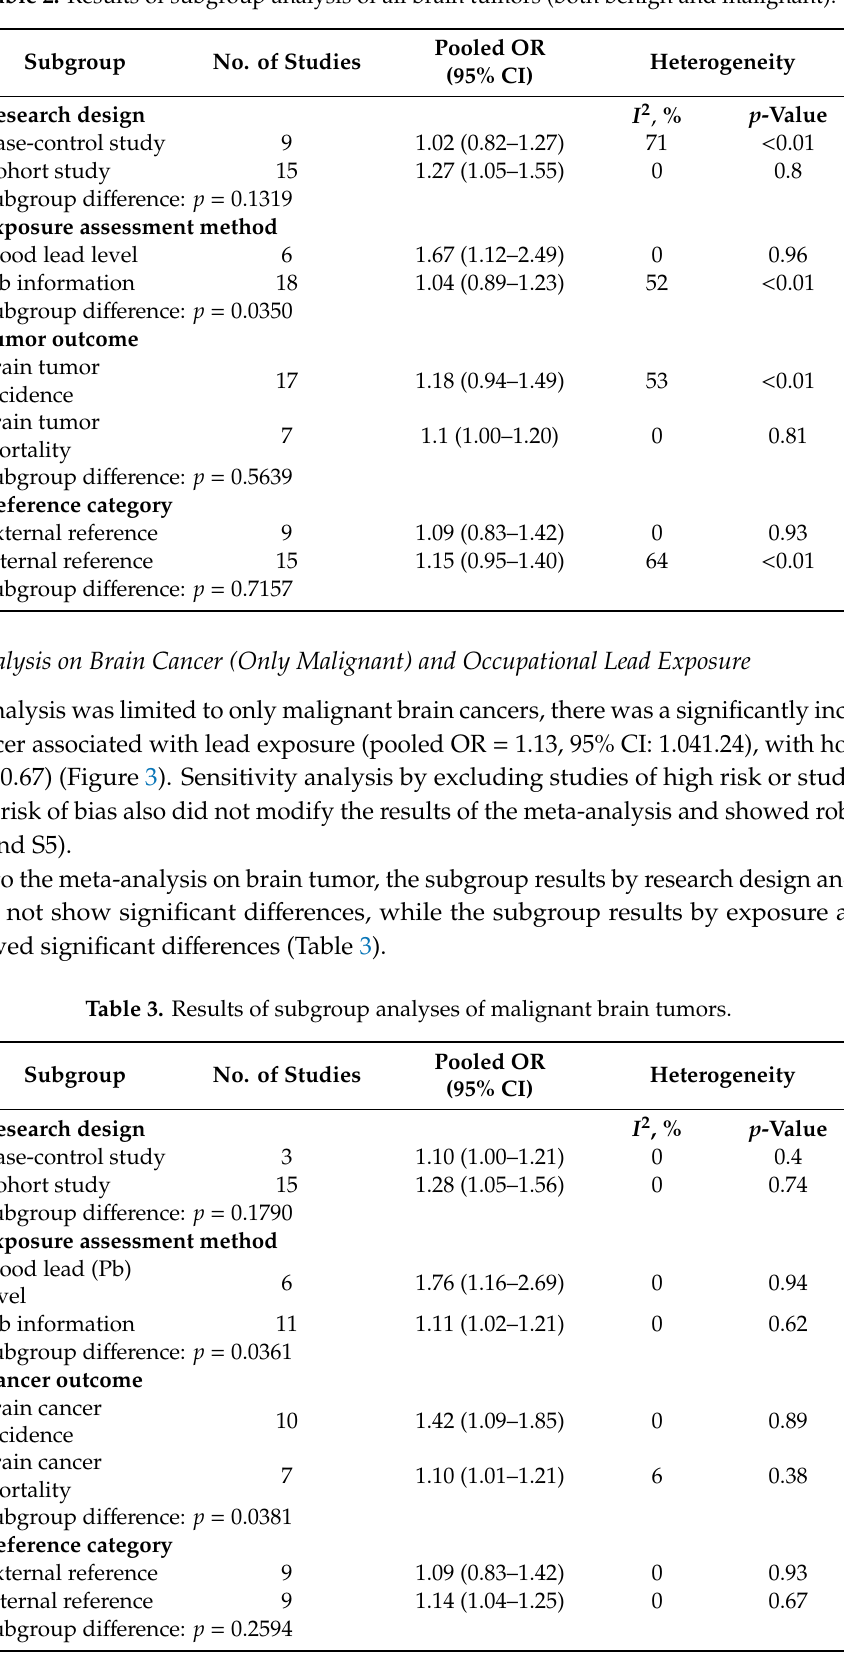
Table 2. Results of subgroup analysis of all brain tumors (both benign and malignant).